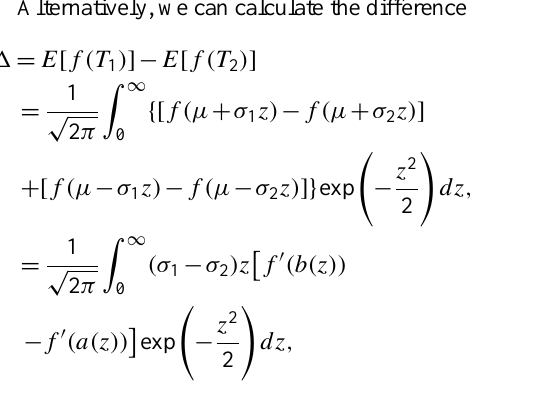
Fig. 1. Graphical representation of changes in the mean and stan- dard deviation on a Gaussian climate distribution A with mean T0 and standard deviation S0 resulting in distribution B with mean T and standard deviation S. (a) Probability density functions (pdfs) where the mean from distribution A (continuous) changes to dis- tribution B (dashed), (b) distributions A and B from (a) in a stan- dardized MSC plot showing standardized changes in the mean (T - T0)/S0 against standardized standard deviation S/S0, (c) pdfs where the standard deviation from distribution A changes to distribution B. (d) standardized MSC plot of (c), (e) pdfs where both the mean and the standard deviation from A change to B, (f) standardized MSC plot of (e).